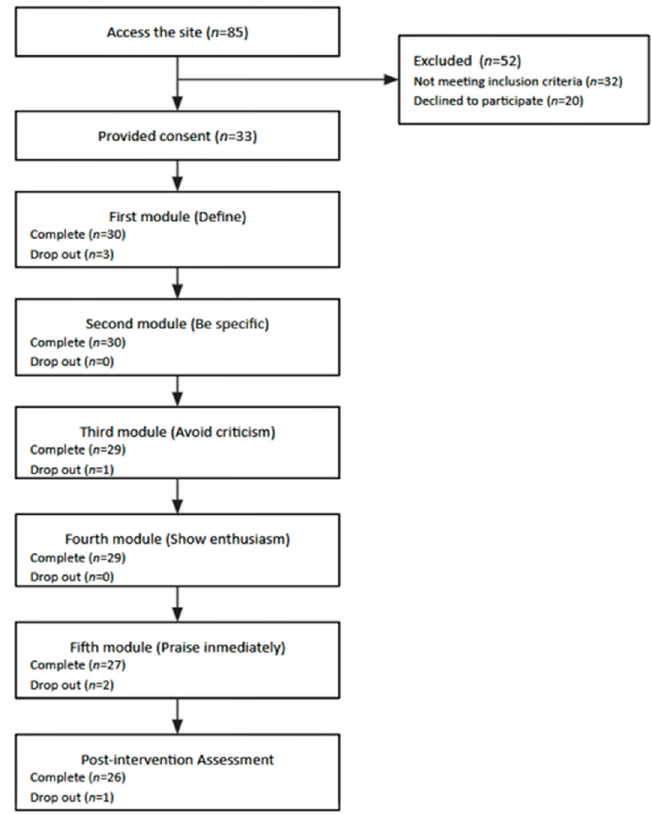
Figure 1. Participants flow. Engagement: The mean number of messages sent per participant to the bot was 54.24 (SD = 13.05). The mean number of characters typed was 98,457.97 (SD = 2569.74). The mean number of words per message sent by participants was 3.00 (SD =